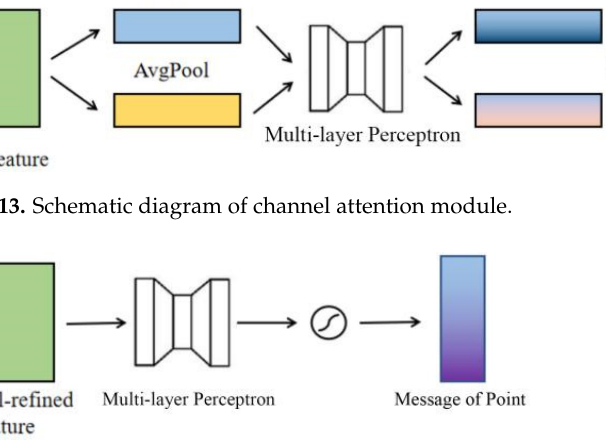
Figure 14. Schematic diagram of point attention module.